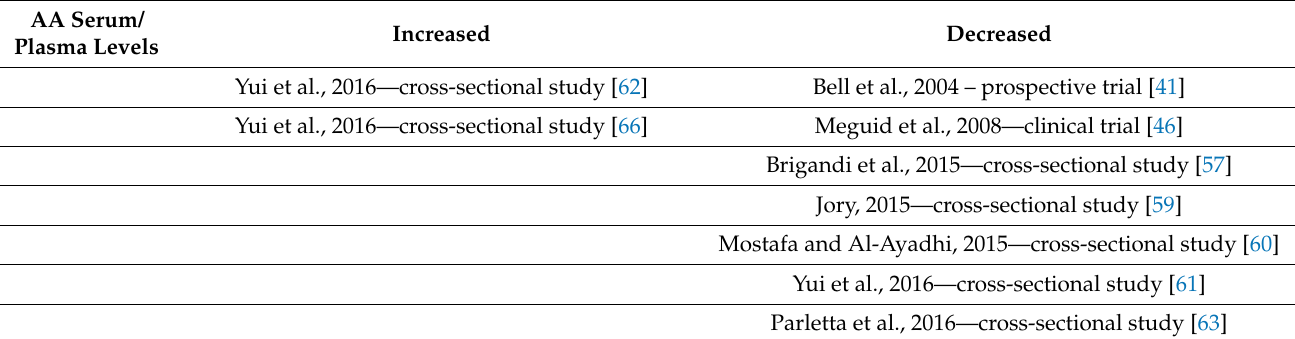
Table 5. Associations between arachidonic acid (AA) serum/plasma levels and Autism spectrum disorders. AA Serum/